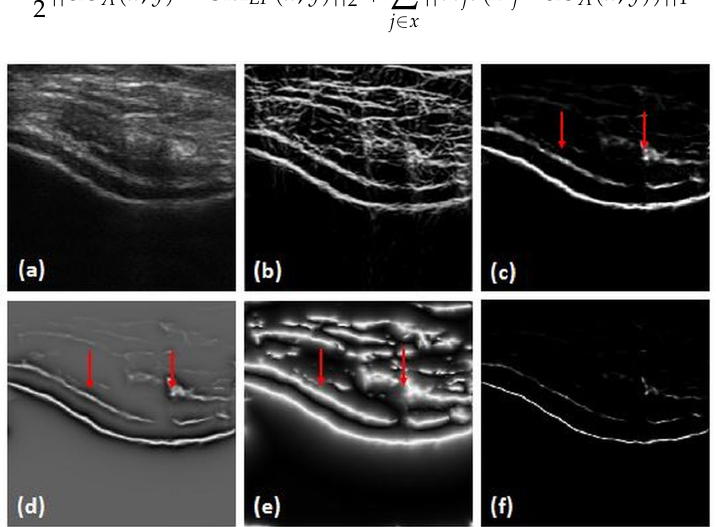
Figure 3. Local-phase image bone features: ( a ) original B-mode US ( x , y ) . ( b ) Enhanced US image USE ( x , y ) . ( c ) Local-phase tensor image ( LPT ( x , y ) ). ( d ) Local-phase energy image ( LPE ( x , y ) ). ( e ) Local weighted mean phase angle image ( LwPA ( x , y ) ). ( f ) Local-phase bone image ( LP ( x , y ) ). Red arrows point to extracted soft-tissue interfaces where enhancement was